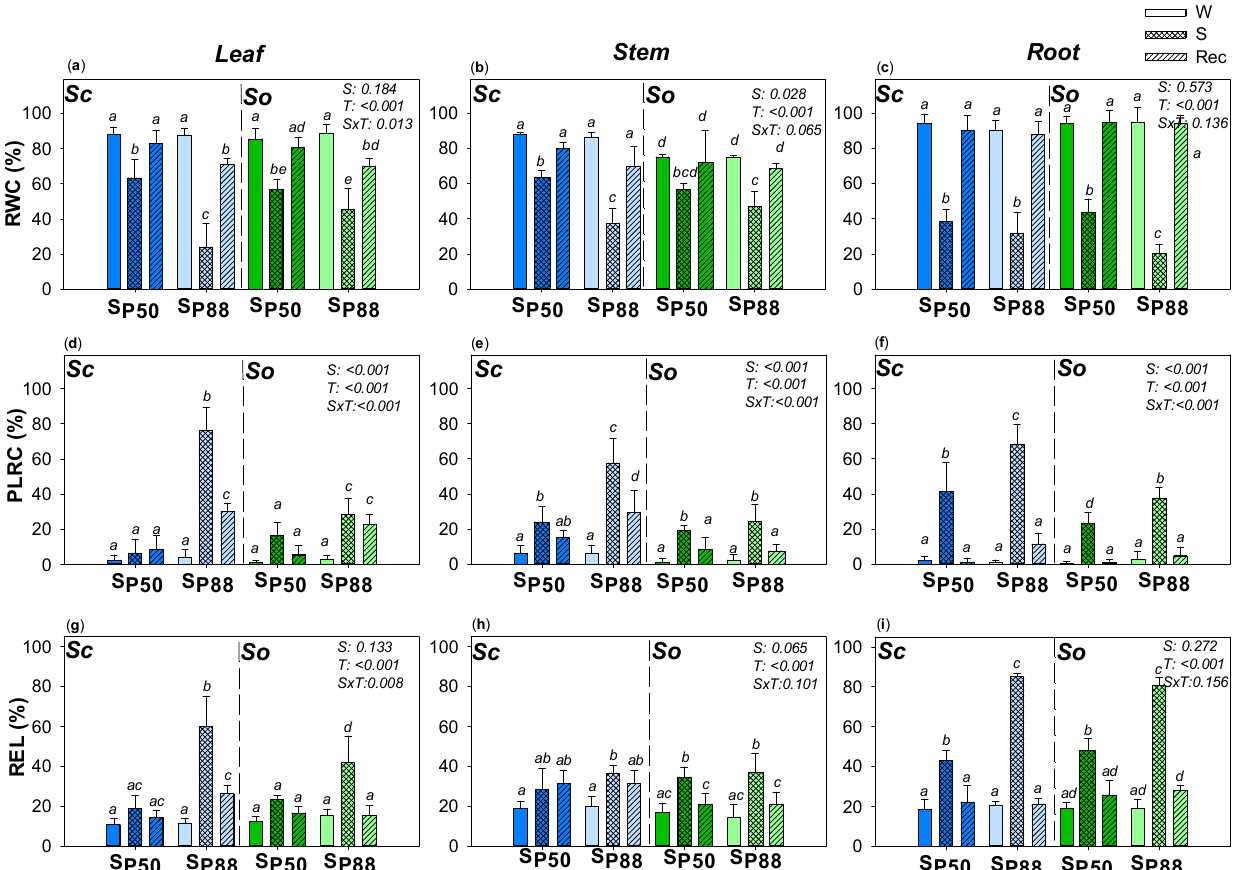
Figure 2. Effect of experimental treatments on water content and drought-driven damages. Mean ± SD ( n = 5) values of relative water content (RWC); percentage loss of rehydration capability (PLRC) and relative electrolyte leakage (REL) as recorded in leaf ( a , d , g ), stem ( b , e , h ) and root ( c , f , i ) samples of well-watered (W, none pattern), water-stressed (S, slanting dash) and re-irrigated (Rec, mesh dash) plants of S. ceratophylloides ( Sc , blue columns) and S. officinalis ( So, green columns) submitted to two different water stress levels, i.e., S P50 and S P80 (for details, see the text). p values as obtained by the two-way ANOVA analysis are reported. Different letters indicate statistically significant differences between groups.